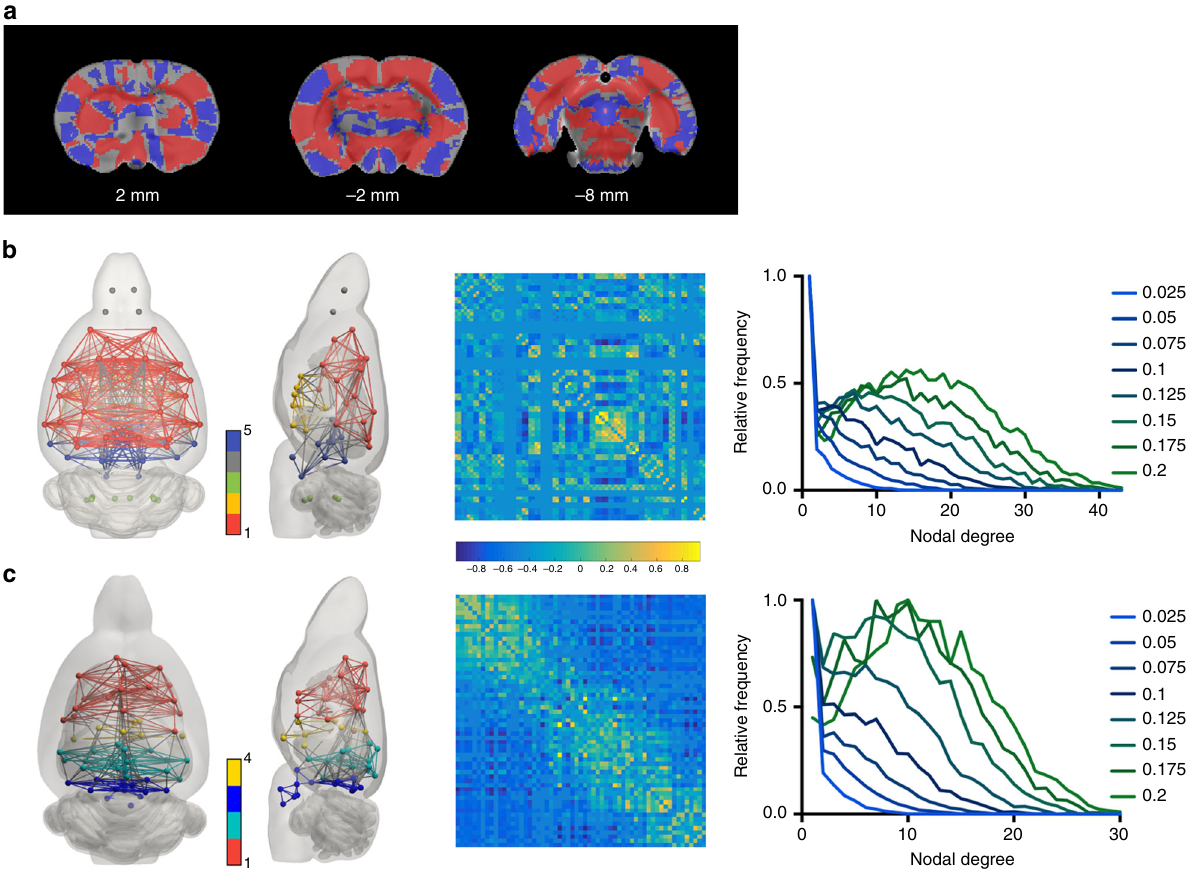
Fig. 7 Functional connectivity analysis performed with anatomical or functional atlas. a Signi fi cant differences ( p < 0.05, non-parametric permutation- based group comparison with a Student t -test, corrected for multiple comparisons using Family Wise Error) in the voxel-mean ROI signal variability. Red represents reduced variability using the functional atlas while blue represents increased variability. Functional connectomes built with b the SIGMA anatomical atlas and c the SIGMA functional atlas. Each module within the network is coded by the node color. Shown here are the average networks visualized using BrainNet Viewer (left), the average connectivity matrices (center) and the plots of the degree distribution for densities between 0.025 and 0.2. ( t = 0.41, df = 78, p = 0.68, two sample Student t -test). Source data are provided as a Source Data fi